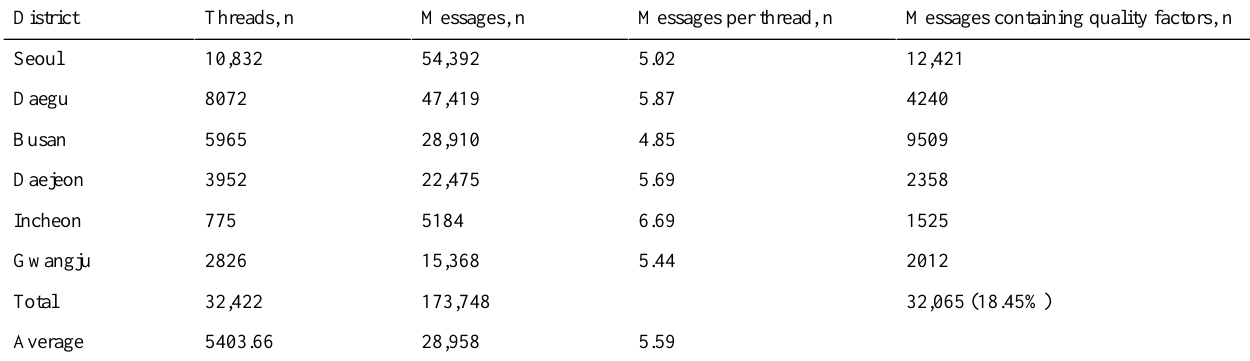
Table 1. Data statistics (from Naver and Daum Web